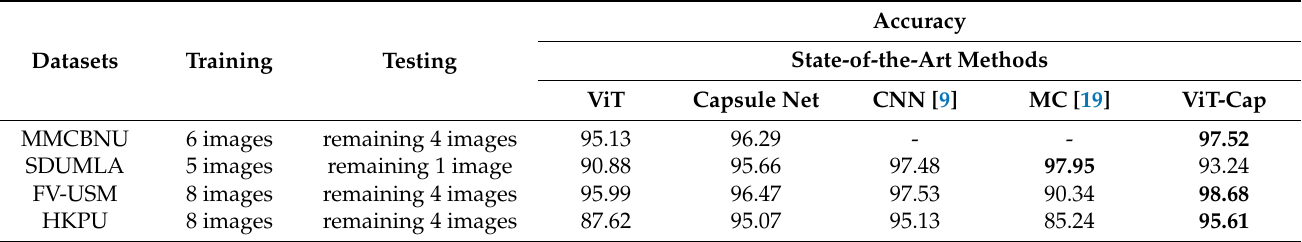
Table 5. Comparison with state-of-the-art methods of finger vein